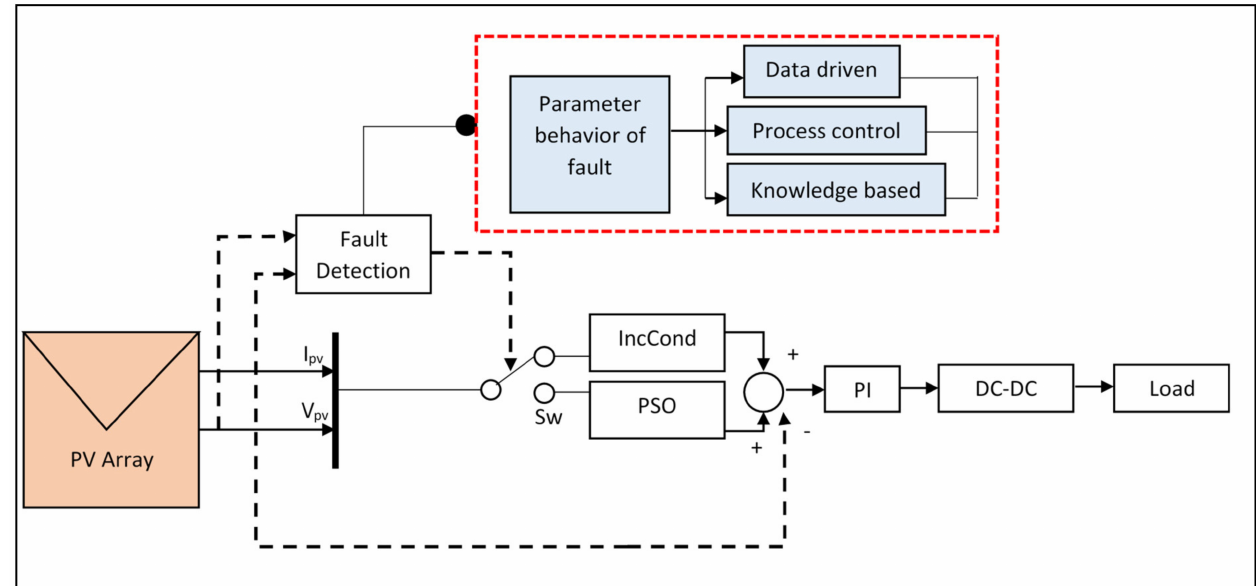
Figure 13. The architecture of proposed fault detection schemes for grid-interconnected renewable energy